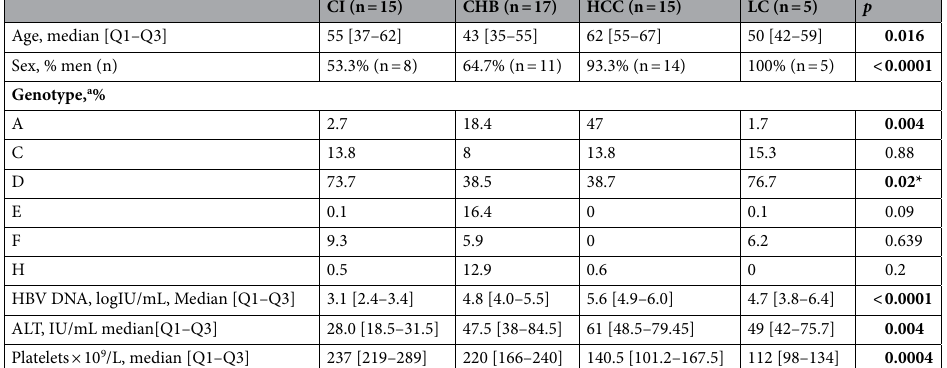
Table 1. Main viral and serologic characteristics of the clinical groups enrolled in the study. CHB chronic hepatitis B, LC liver cirrhosis, HCC hepatocellular carcinoma, CI chronic infection; Q1, 25th percentile; Q3, 75th percentile; HBV hepatitis B virus, ALT alanine aminotransferase. p values ( p ) were obtained by applying the Kruskal–Wallis test in median age, HBV DNA and ALT, and by ANOVA in genotype distribution. Statistically relevant p values are reported in bold. * p > 0.05 when Tukey multiple comparison was implemented. a Genotype was evaluated by NGS sequencing, as described 16